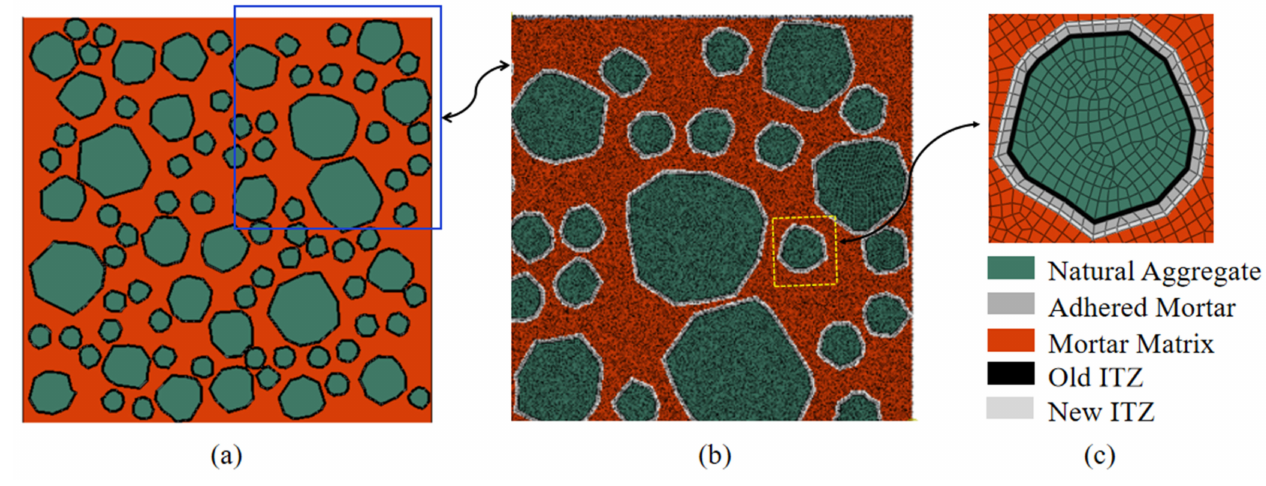
Figure 2. The meso-scopic model of RAC. ( a ) Aggregate model; ( b ) Meso meshing; ( c ) Meso componet.